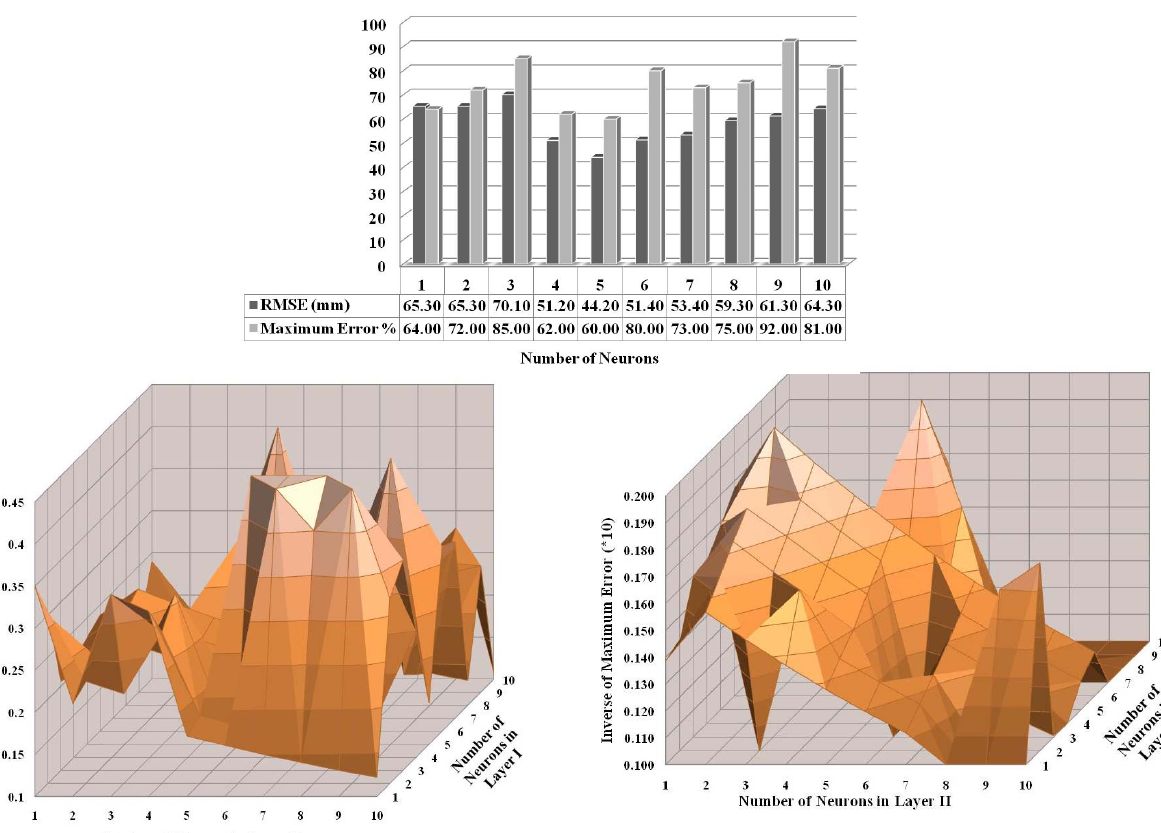
Fig. (12). Neural Network Performance “RMSE and maximum error%” utilizing different Architecture, (a) one hidden layer (b) & (c) two hidden layers Fig. 12. Neural network performance “RMSE and maximum error%” utilizing different architecture, (a) one hidden layer (b) and (c) two hidden layers. Table 2. Maximum RE% and correlation coefficient associated with the output of ANN and ARMA models on a weekly/monthly basis for years 2007 and 2008.